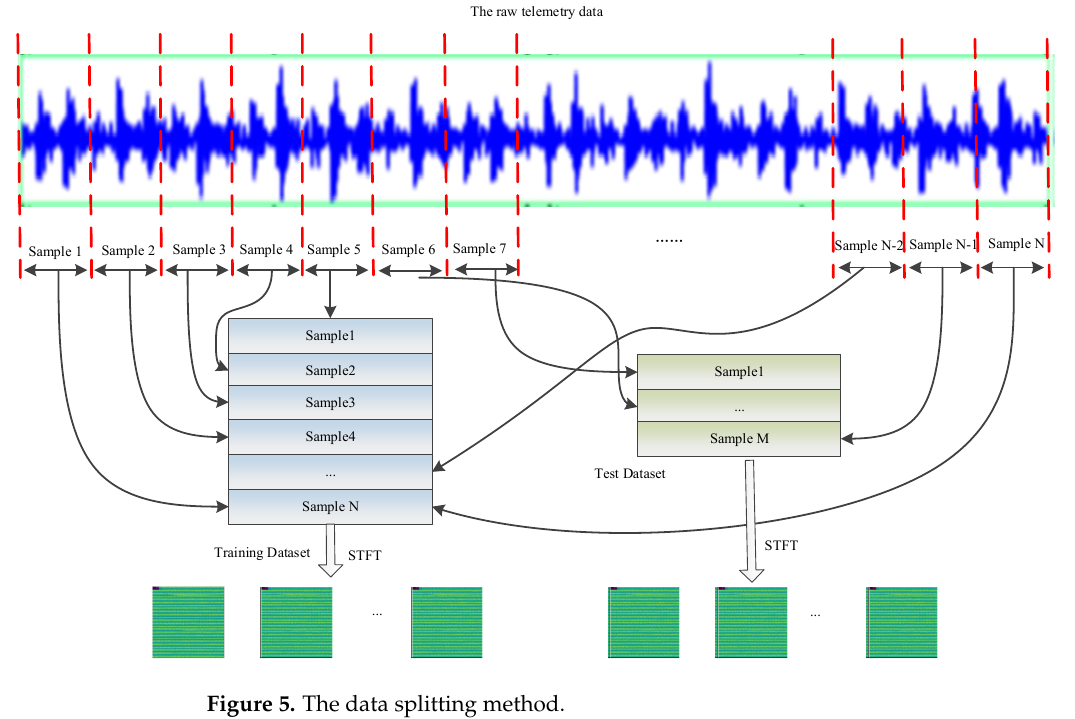
Figure 5. The data splitting method.